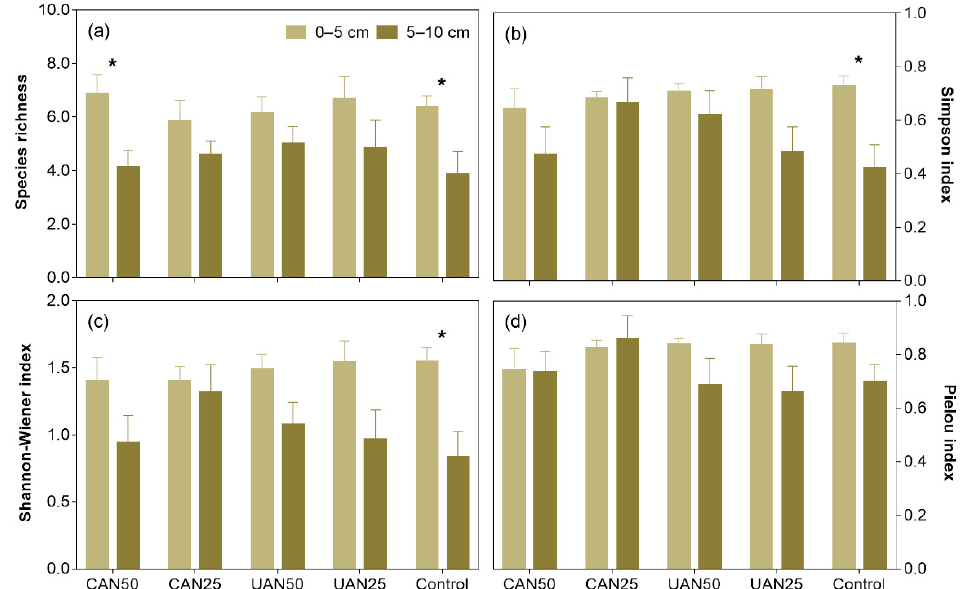
Figure 2. Species richness ( a ), Simpson index ( b ), Shannon–Wiener index ( c ), and Pielou index ( d ) of the soil seed banks as affected by soil layer and five N-addition treatments. Values are means + standard error of mean (SEM). * Indicates a significant difference between the two soil layers within the same N-addition treatment. Treatments are described in Table 1 and in the text.